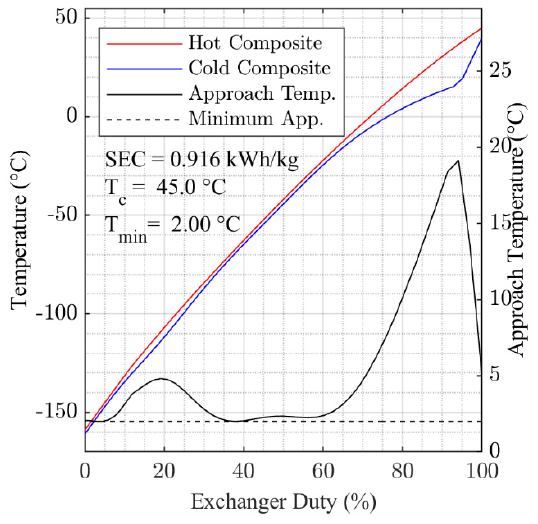
Figure A8. Optimized composite cooling curves for 40°C cooling temperature.